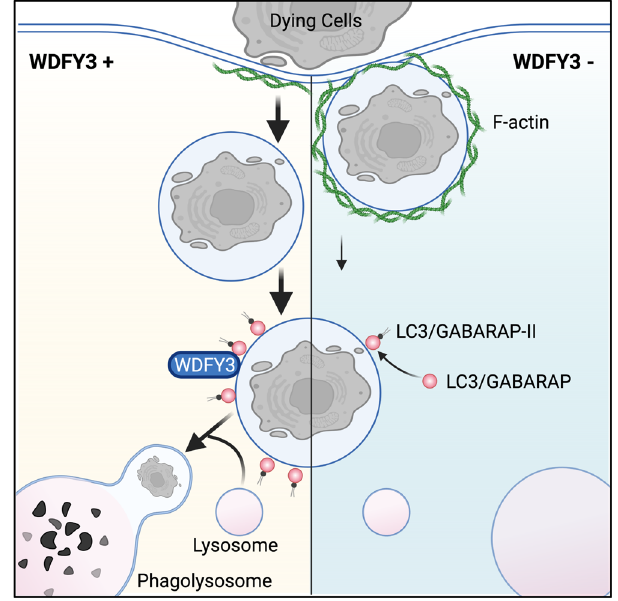
Fig. 7 | Schematic fi gure summarizing how WDFY3 regulates macrophage efferocytosis. WDFY3 is discovered as a new regulator of efferocytosis by macro- phages. WDFY3 de fi ciency in macrophages speci fi cally impaired uptake, not binding, of apoptotic cells due to defective actin depolymerization, thus phago- some formation. WDFY3 directly interacts with GABARAP, one of the seven mem- bers of the LC3/GABARAP protein family, to facilitate LC3 lipidation and the subsequent phagosome-lysosome fusion and degradation of the engulfed AC